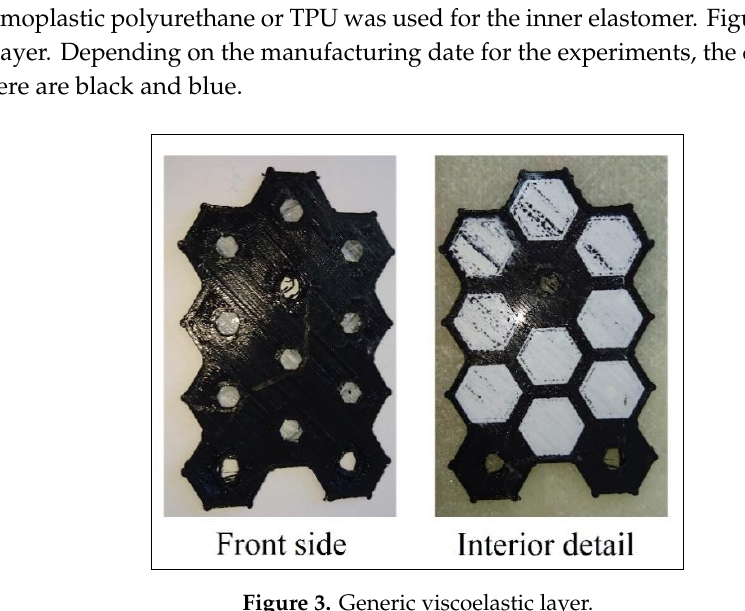
Figure 3. Generic viscoelastic layer.